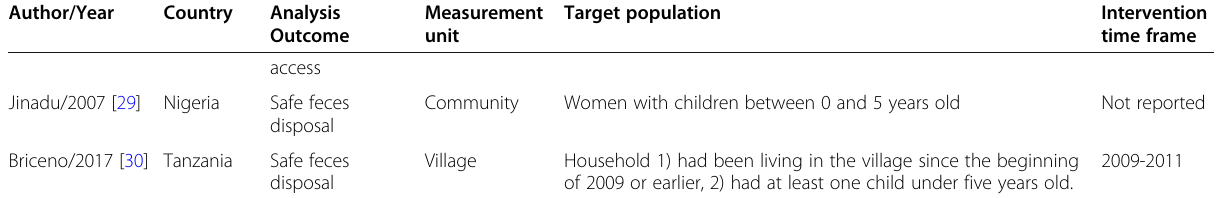
Table 1 Characteristic of included in meta-analysis